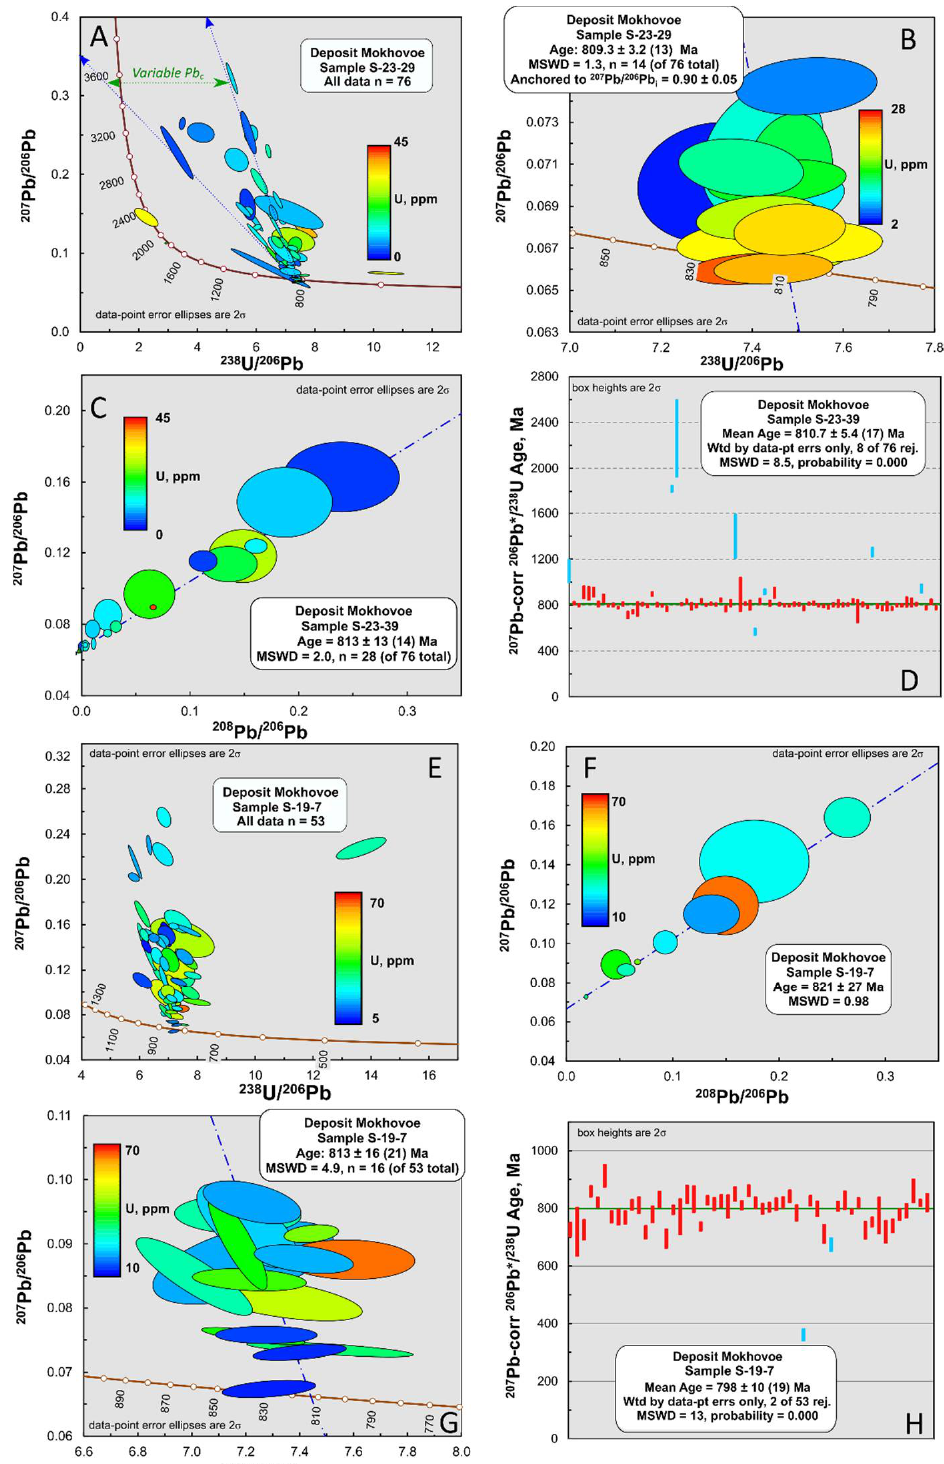
Figure 15. The U-Pb isotope data for cassiterite samples S-23-39 ( A – D ) and S-19-7 ( E – H ) from the Mokhovoe deposit. Tera-Wasserburg isochron diagrams ( A , B , E , G ), inverse Pb-Pb isochrons ( C , F ) and weighted averages of the 207 Pb-corrected 206 Pb*/ 238 U ages ( D , H ) are also shown. The vertical lines in ( D , H ) represent age values with 2 standard error (2 SE) bars. The blue lines are outliers not included in the weighted average calculation.